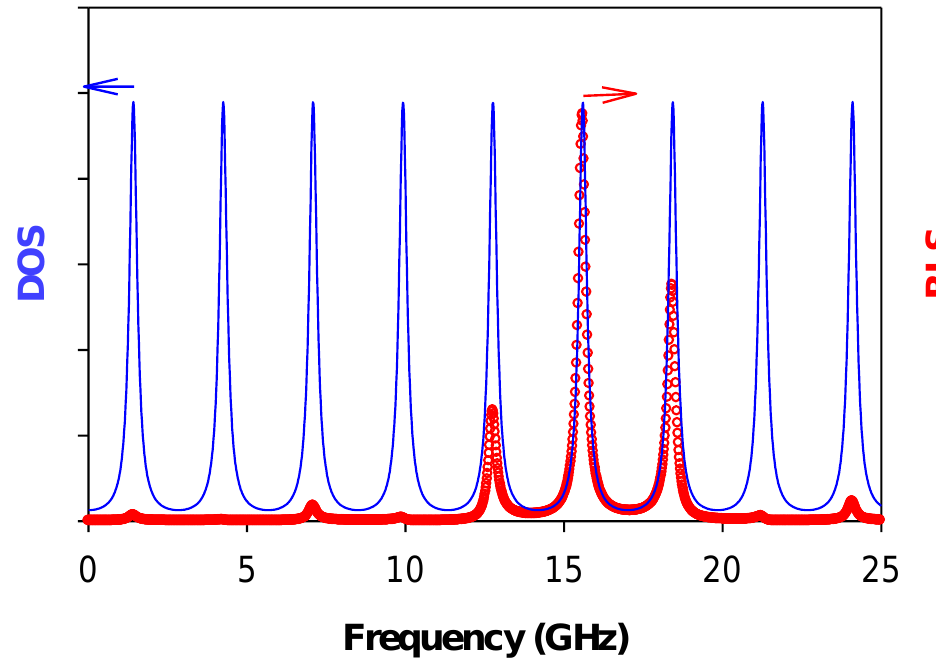
Figure 5. Variation of the DOS (blue curves) and BLS intensity (red curves) as a function of the frequency for the PMMA layer of thickness 𝑑 = 490 nm.